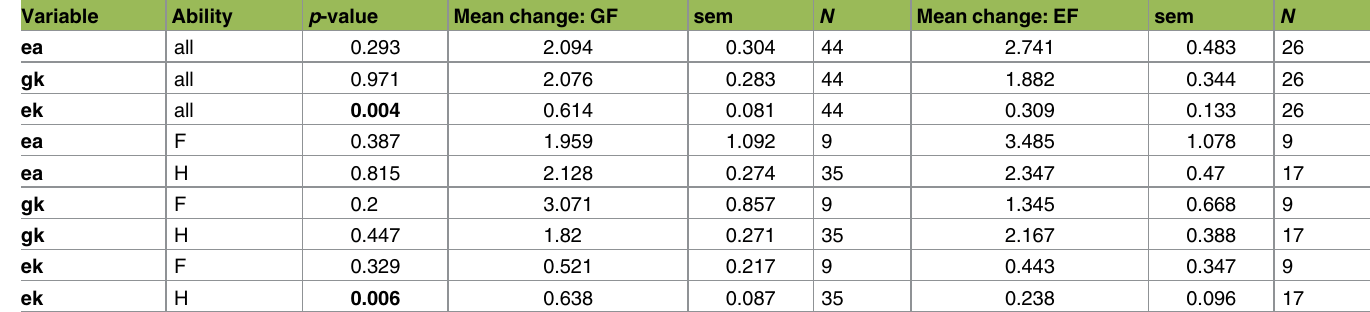
Table 4. Class-level analysis of change in 3 scores as a function of teaching order. p -Valueis from a Mann Whitney U test. Ea = Evolutionacceptance, gk = geneticsknowledge,ek = evolutionknowledge.EF = evolutionfirst, GF = Genetics first. p -Valuesin bold are significantafter Bonferonnicorrection. Raw data can be found in S1 and S2 Data.